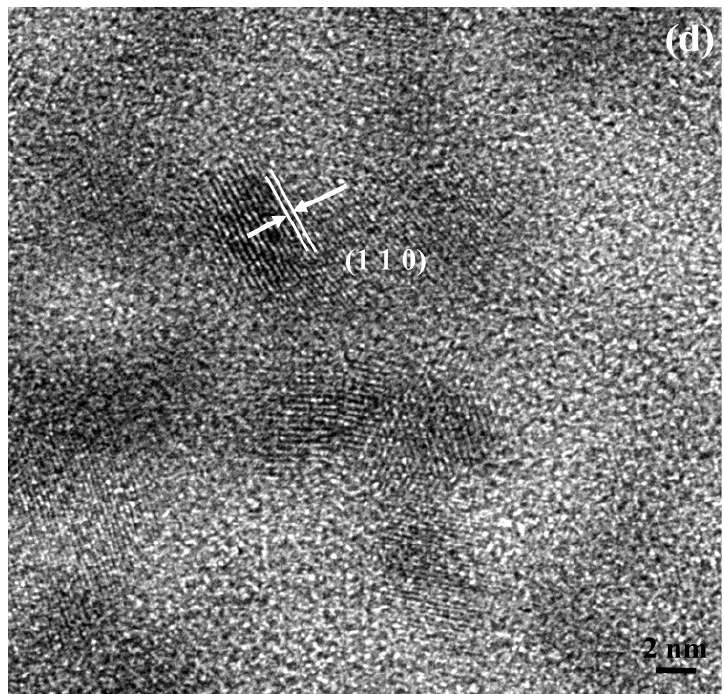
Figure 1. ( a , b ) Scanning electron micrographs; ( c , d ) transmission electron micrographs of the semi- polycrystalline polyaniline.